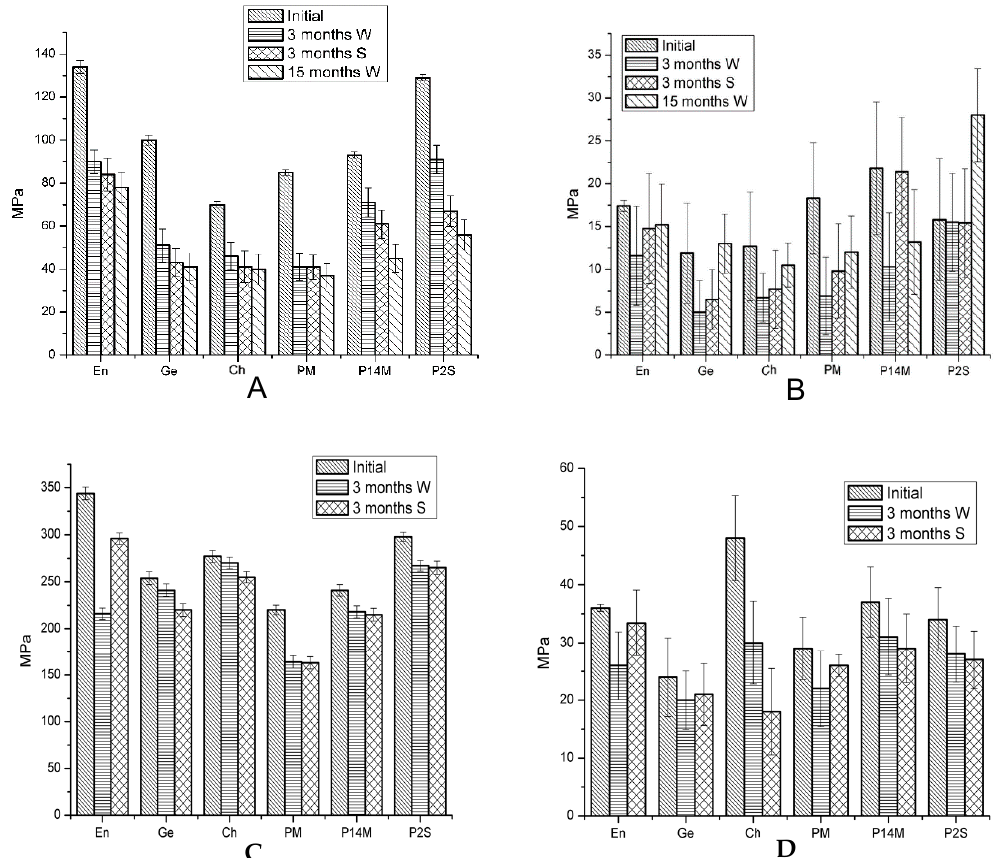
Figure 4. Average values and standard deviations of mechanical properties of flexural strength (FS - graph A ), Young’s modulus of bending (YM—graph B ), compressive strength (CS—graph C ), diametral tensile strength (DTS—graph D ) after the polymerization reaction (initial) and after 3, respectively 15 months (only for FS and YM) of immersion in distillated water (W) and artificial saliva (S); En = Enamel plus HRI, Ge = G-ænial anterior, Ch = Charisma.